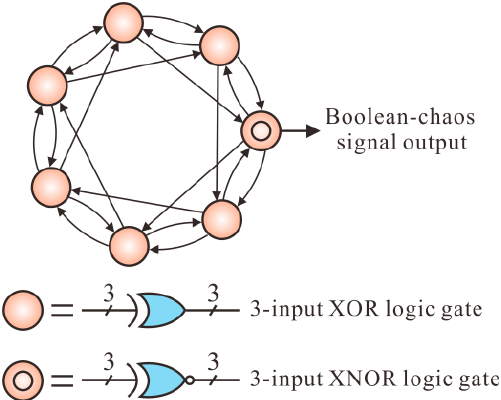
Figure 2. Schematic diagram of the Boolean-chaos signal generator.